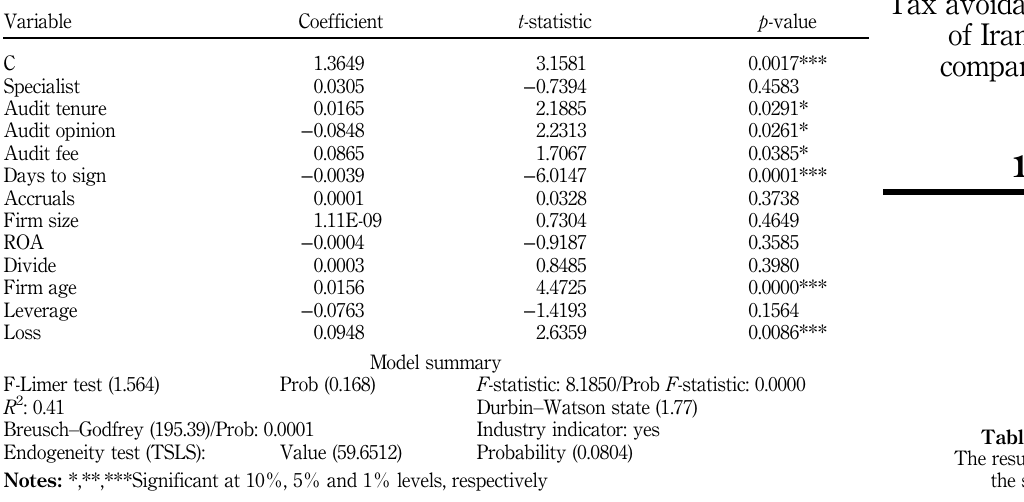
Table VI. The results